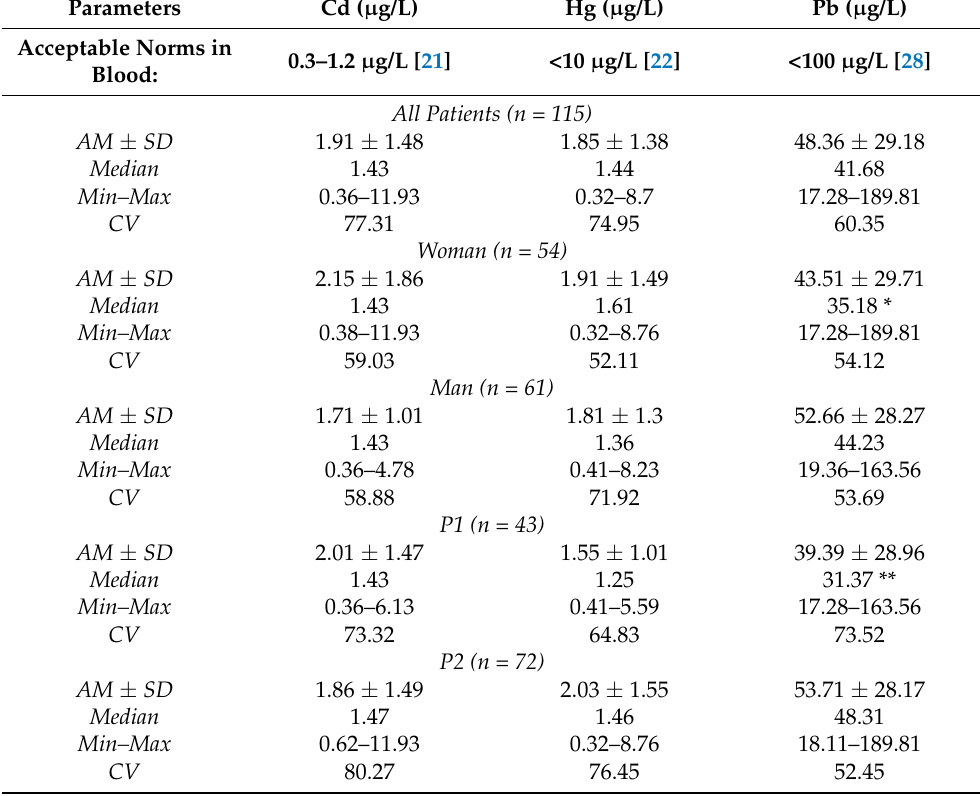
Table 2. Cadmium, mercury, and lead concentrations in erythrocytes of renal transplant recipients; (P1 < 50 years old; P2 > 50 years old; AM: arithmetic mean, SD: standard deviation, Min–Max: minimum and maximum values, CV: coefficient of variation in %; * p < 0.05, statistically significant difference vs. MAN; ** vs.